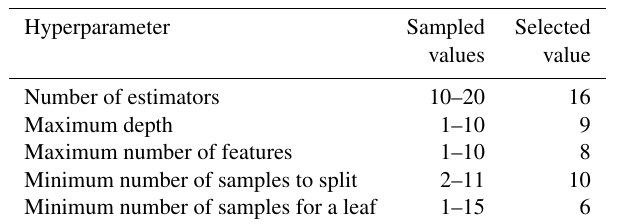
Table 4. Algorithm hyperparameters considered for the random for- est, their sampled values in the cross validation, and chosen value in the final version of the model used in Sect.